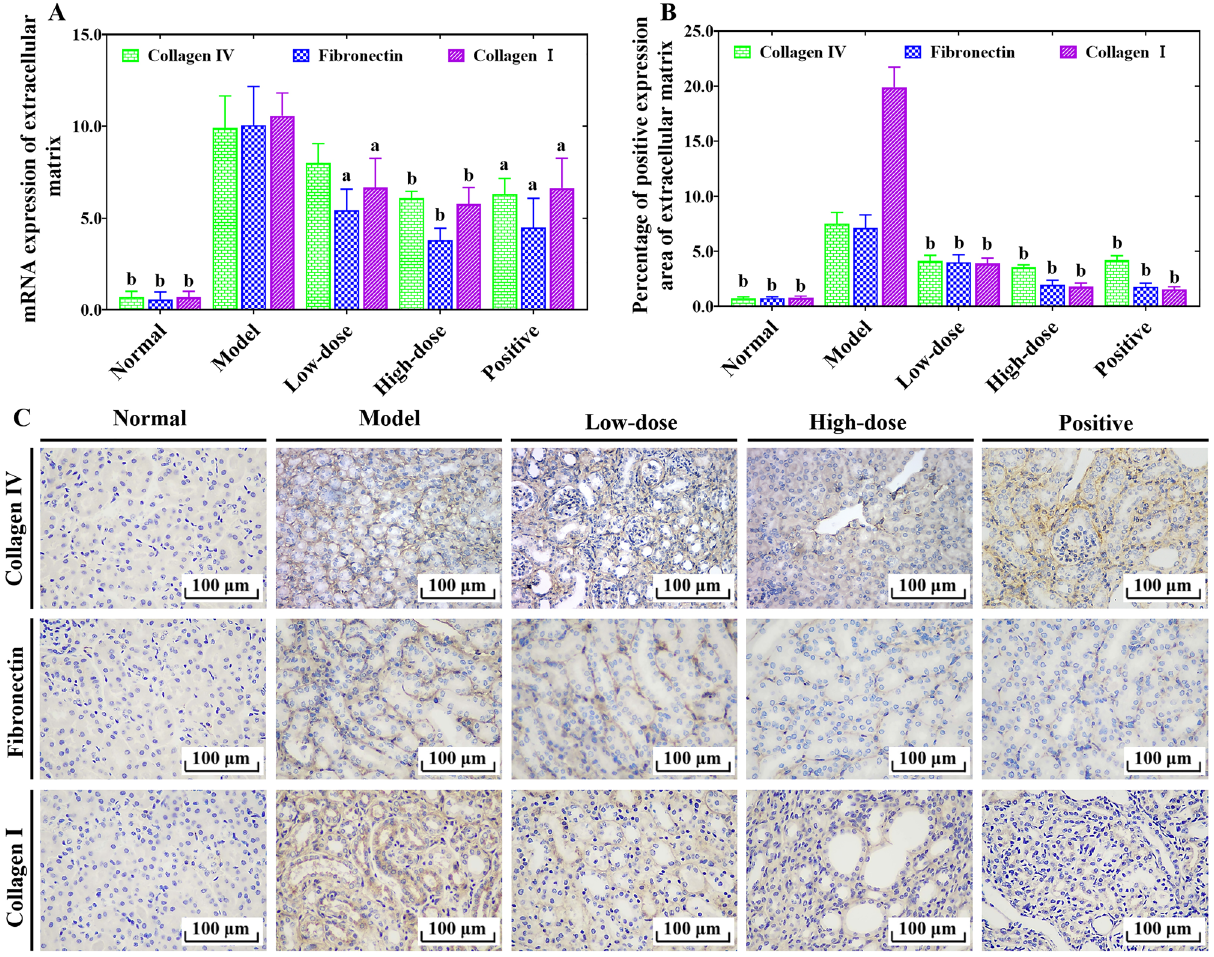
Figure 5. The effects of COS on ECM accumulation of kidney tissues in UUO-induced RF mice. The mRNA expression of ECM ( A ). Percentage from positive staining area of ECM to the entire field of view ( B ). Representative immunohistochemical staining image of ECM ( C ). All values are represented as mean ± SD (n = 10 in each group). Superscript letters a and b designate significant differences. a P < 0.05 compared with the model group. b P < 0.01 compared with the model